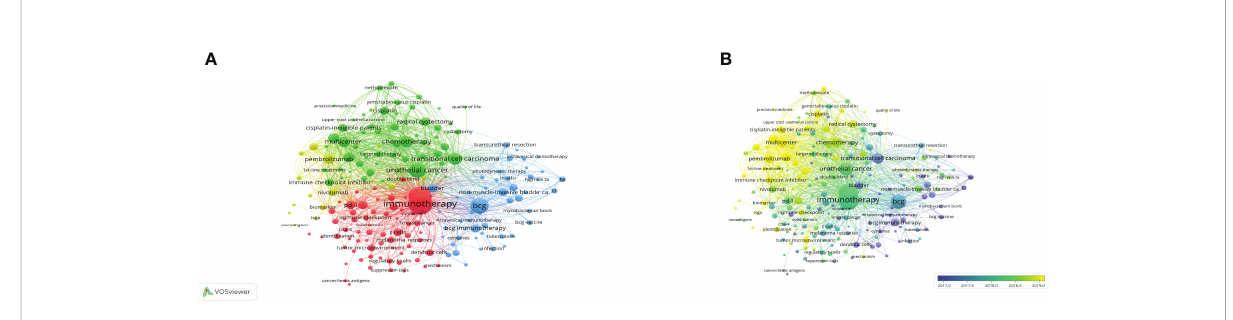
FIGURE 8 The network visualization map (A) and overlay visualization map (B) of the 114 phrases with at least 10 times frequency were created by VOSviewer. The more frequently the keywords appear, the larger the nodes